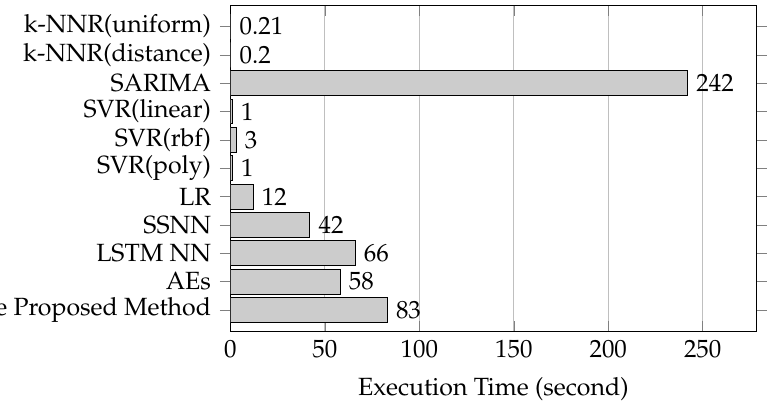
Figure 10. Time costs of the proposed method and the baseline methods.